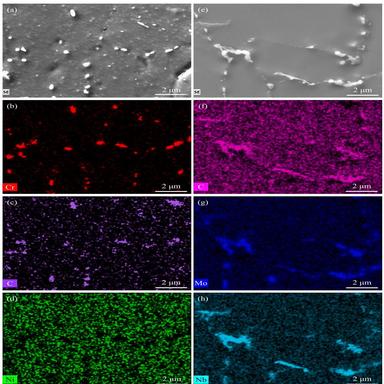
SEM images and EDX maps of the microstructure of (left) IN600 alloy and (right) IN625 alloy.